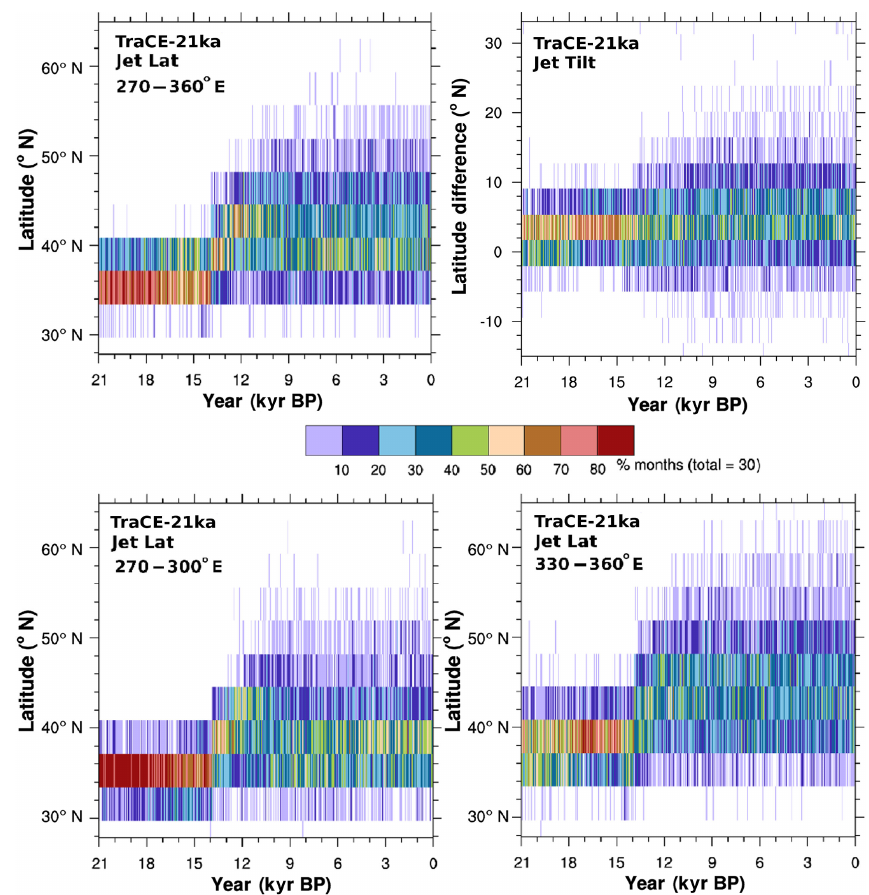
Figure 12. Frequency maps for the NAtl jet derived from the TraCE-21ka deglacial experiment over 700 to 925hPa for jet latitudes evaluated over longitudes 270 to 360 ◦ E, as well as the upstream (270–300 ◦ E) and downstream (330–360 ◦ E) regions and their difference (i.e. jet